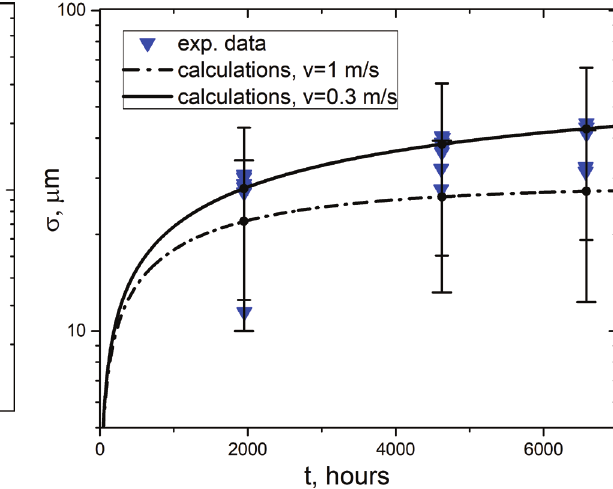
Figure 10. Calculated results and experimental data based on static and dynamic experiments for 316L steel (Balbaud-Celeri- er et al. 2004). The calculated error is 55% for a dynamic exper - iment and 30% for a static.